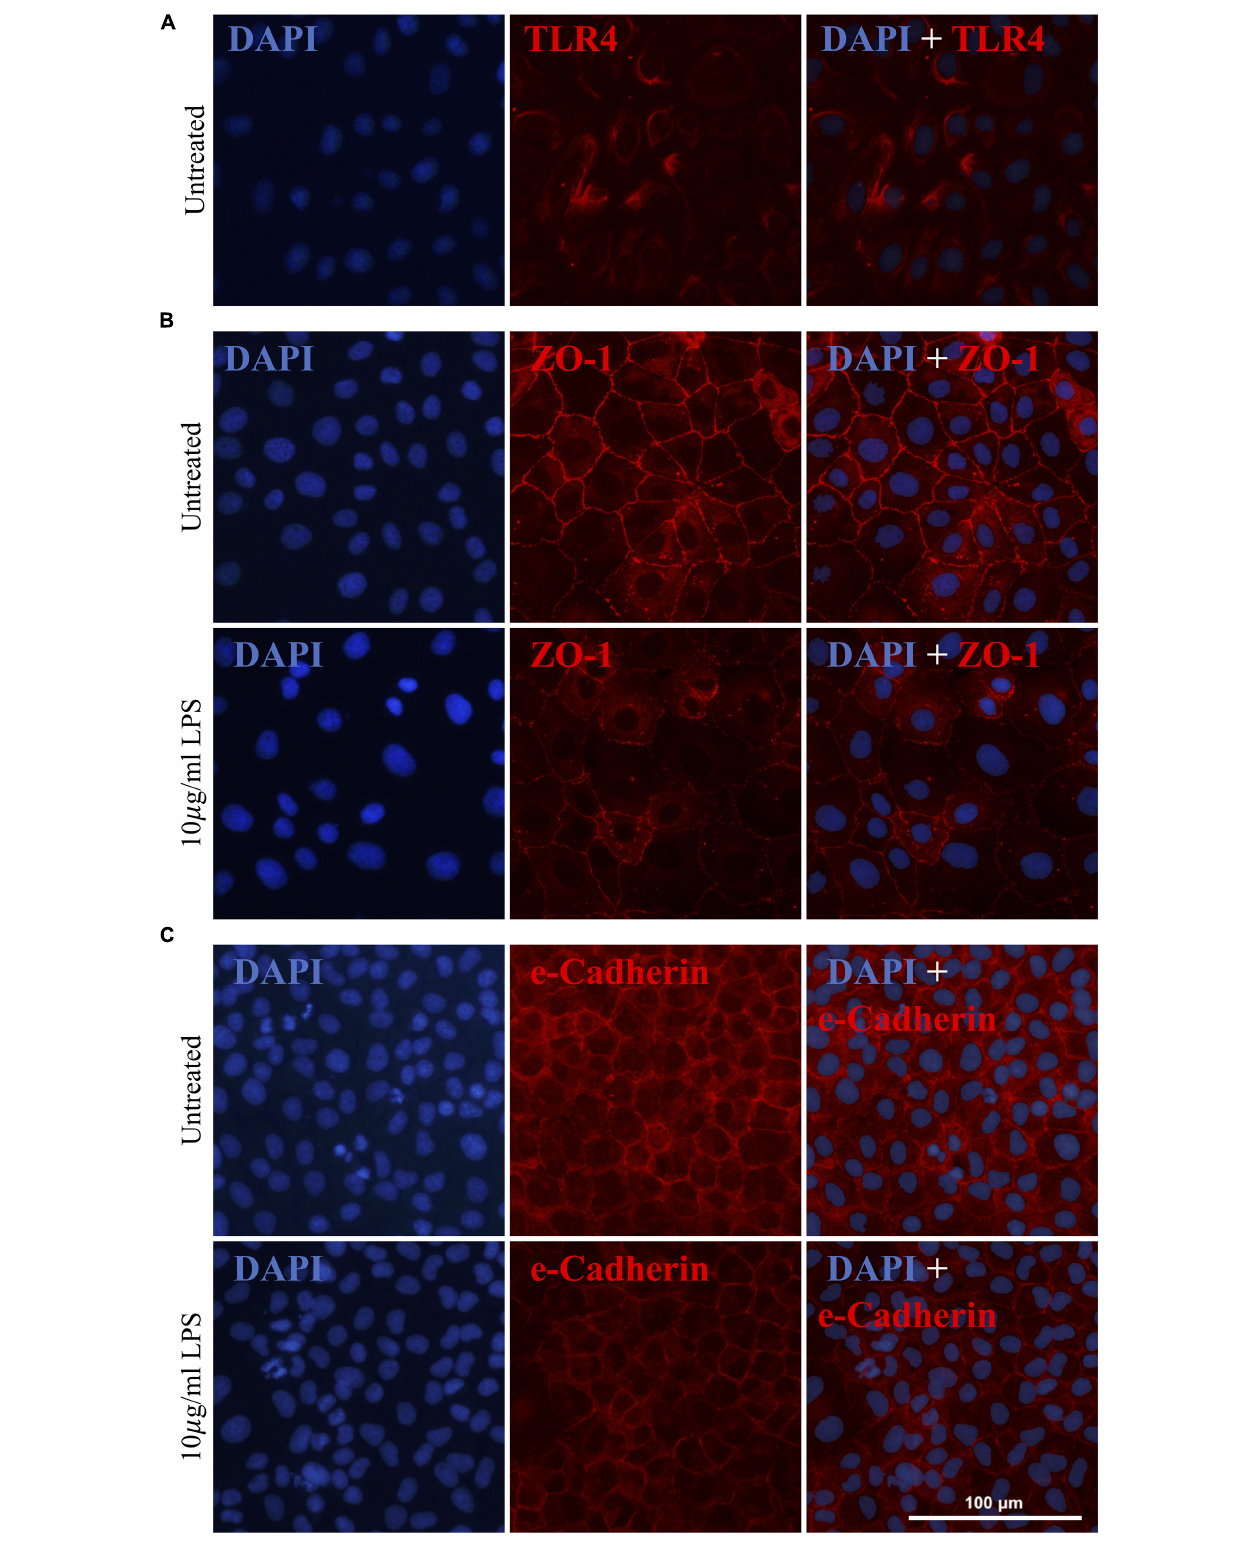
FIGURE 4 | Gammaproteobacteria-produced LPS treatment increases intestinal permeability in vitro . IEC-6 cells express TLR4, a known LPS receptor (A) . Acute LPS treatment (10 µ g/ml for 4 h) resulted in a noticeable reduction of and alteration in the distribution of ZO-1 (B) and e-Cadherin (C) .